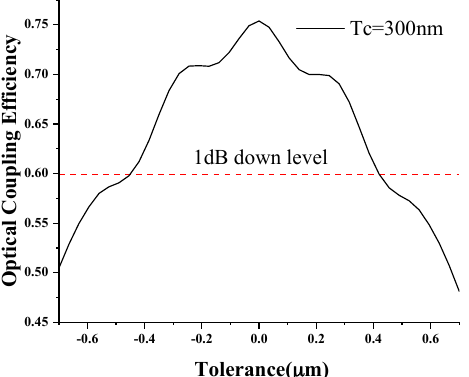
Figure 5. The optical coupling efficiency with the fabrication tolerances of the 0.97 um length buffer.